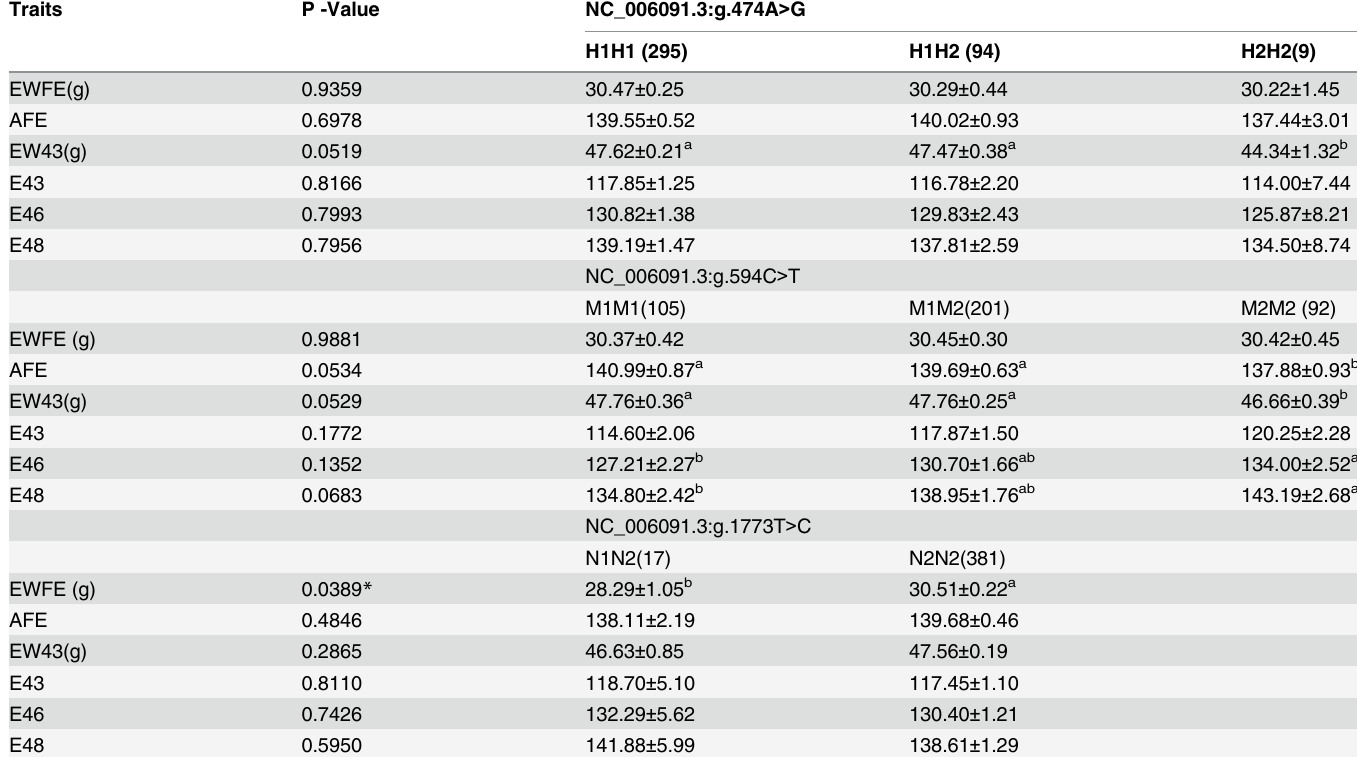
Table 4. Least-squares means and standard errors for reproduction traits of different genotypes in SNPs. Traits